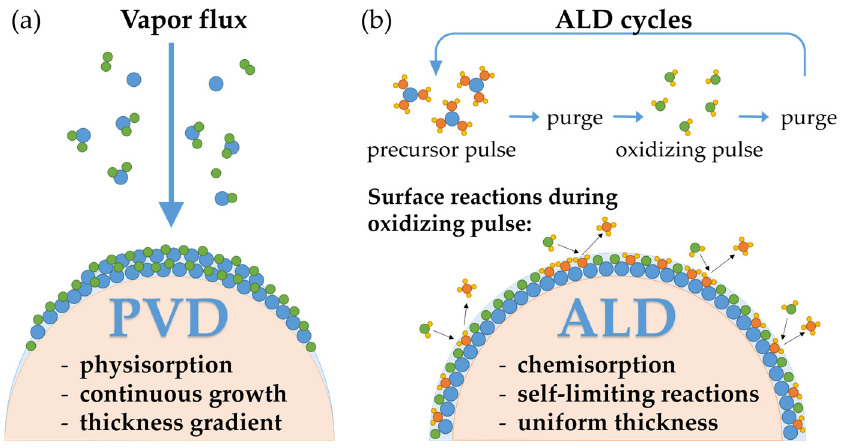
Figure 1. Illustration of ( a ) physical vapor deposition (PVD) deposition and ( b ) atomic layer deposition (ALD) on a hemispherical lens.